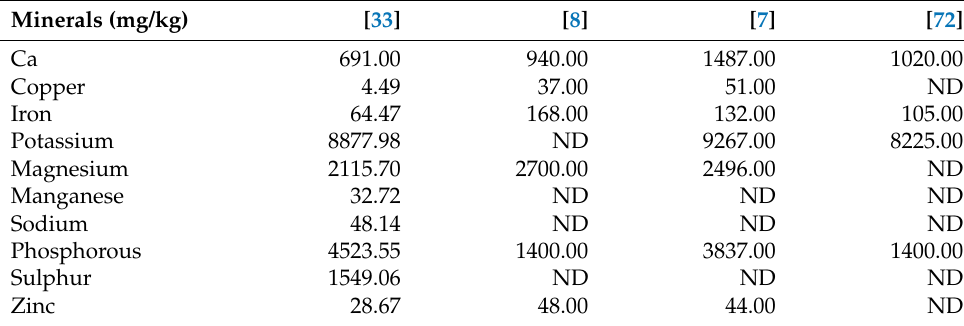
Table 3. Comparative mineral analysis of quinoa grains based on published reports